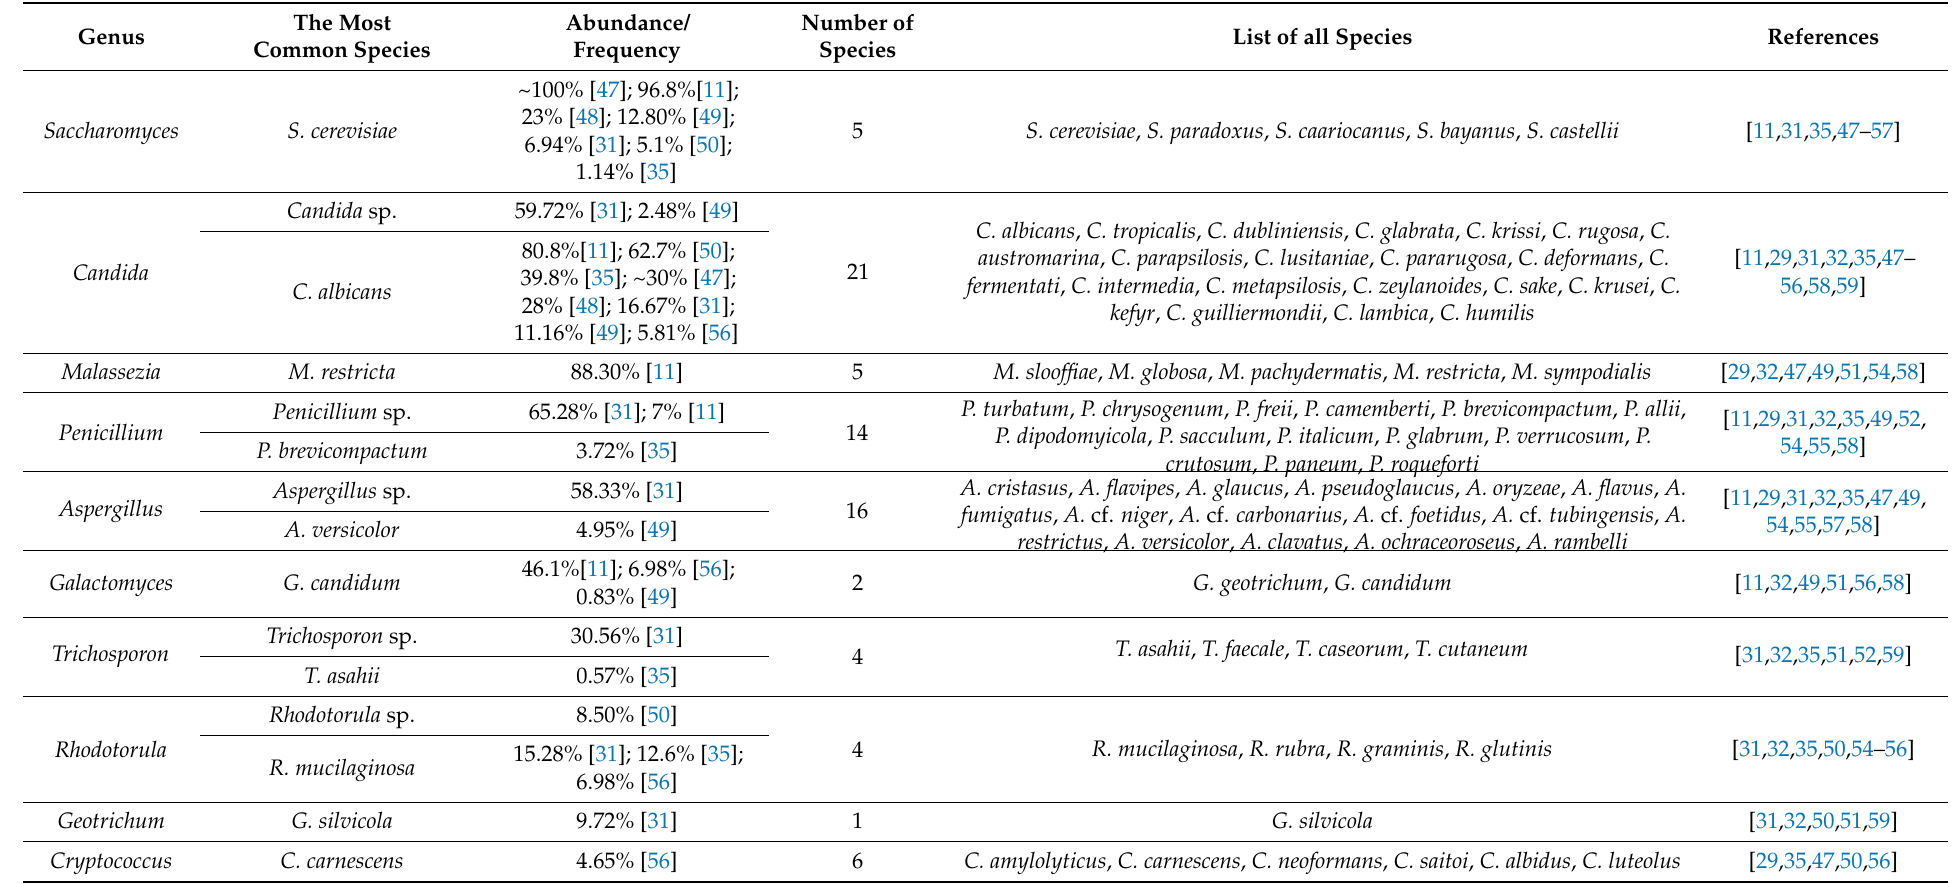
Table 1. The list of chosen gut mycobiome colonizers. The table summarizes the relative abundance (or frequency) of representative taxa, number and summary of all species described in the